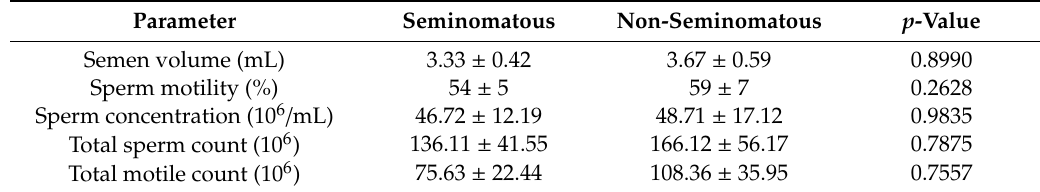
Table 1. Semen parameters of patients ( n = 15 per group) with seminomatous and non-seminomatous testicular germ cell